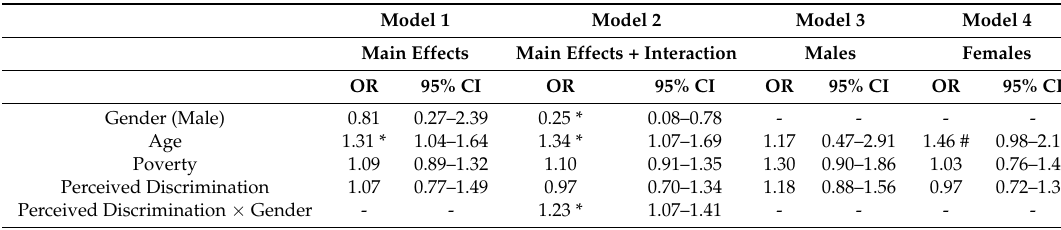
Table 4. Logistic regressions on the association between perceived discrimination and smoking among Caribbean Black youth Model 1 Model 2 Model 3 Main